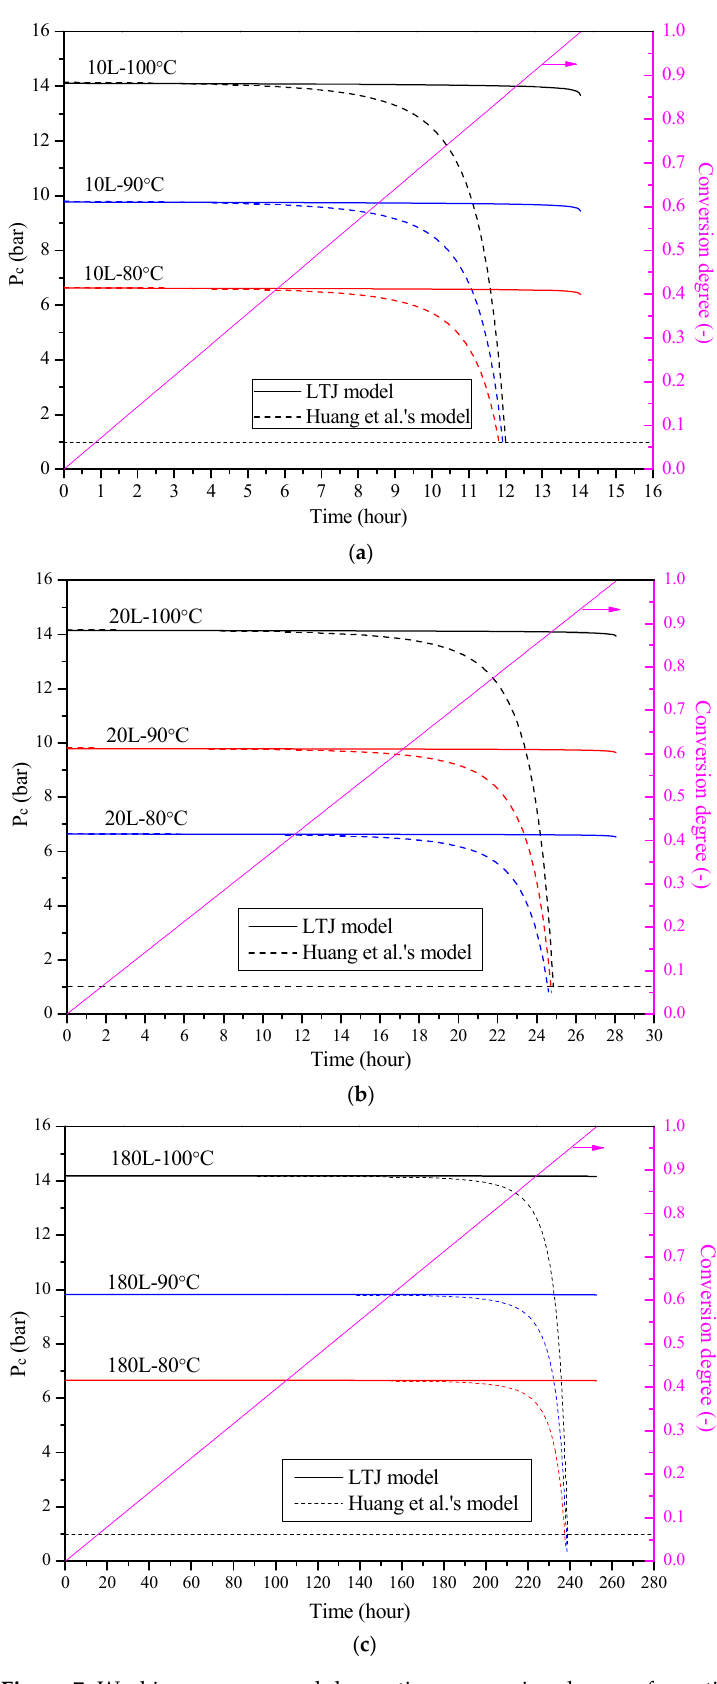
Figure 7. Working pressure and desorption conversion degree of sorption-SCR system in Mode 8, calculated with LTJ model and Huang et al.’s model: ( a ) 10 L reactor; ( b ) 20 L reactor; ( c ) 180 L reactor.